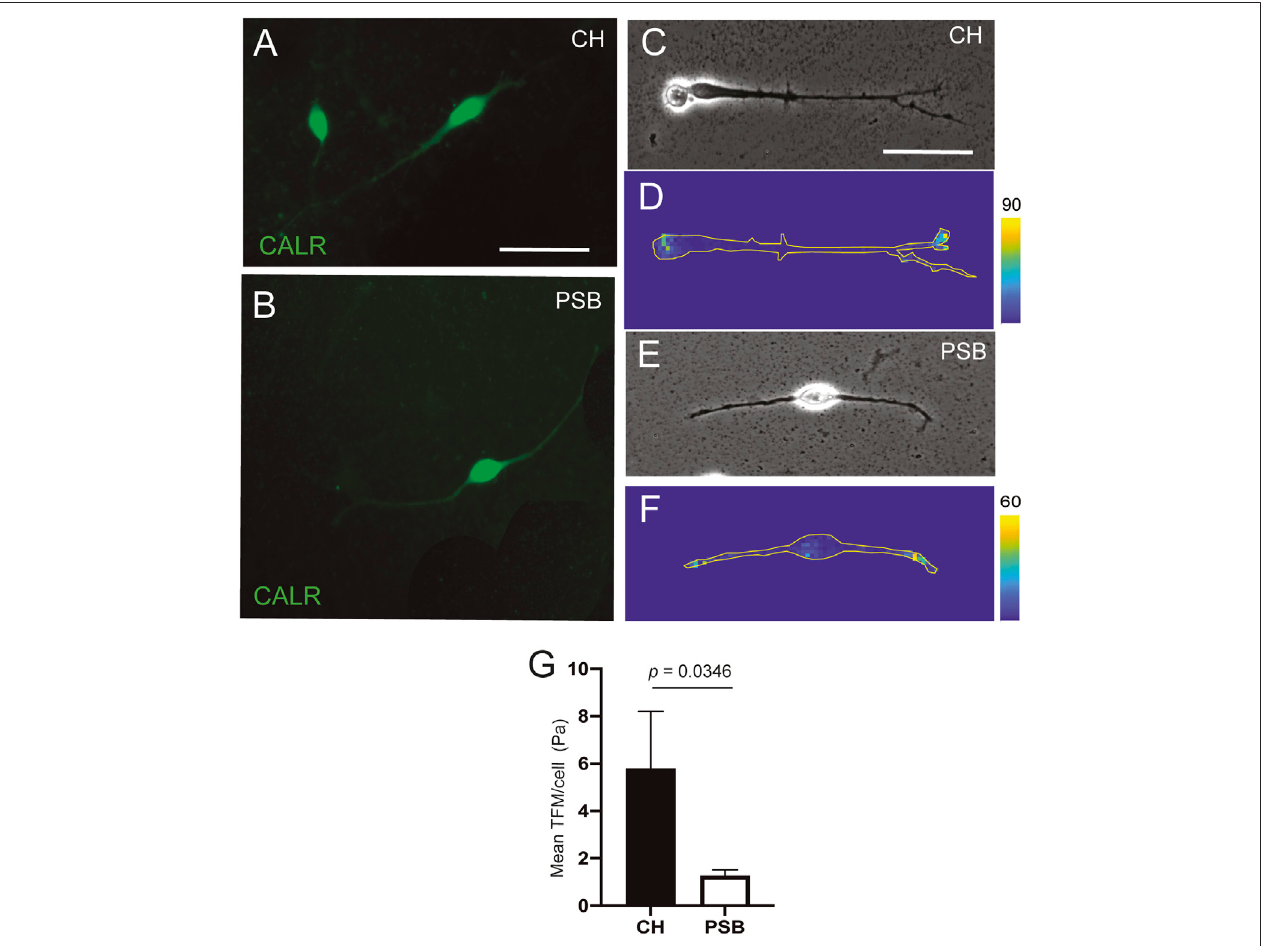
FIGURE 2 | TFM measurements of CH and PSB-derived CR cells in PAA gels (A,B) Examples of CR cells stained using CALR antibodies derived from CH (A) and PSB (B) . (C – F) Phasecontrast(cande)andconstraintforcemaps(DandF)ofCRcellsderivedfromCH (C,D) andPSB (E,F) afterTFManalysis.Forcestriggeredbythe CR cells are color-coded according to their intensity. The shape of the CR cells is outlined with a yellow contour in the constraint maps to better visualize their extent. Thesemapsrevealsthatthehighesttractionvaluesaremorphologicallylocatedatthetipsoftheirneurites,forbothCH-andPSB-derivedCRcells (G) Resultsofthe Traction Force Microscopy (TFM) analysis. The bar plots show the mean pressure (force per unit area) generated by the different CR cells. The pressure values are obtainedbydividingthemeasured forcesbythetotalareapixelsoccupiedbytheanalyzed CRcells.CH:corticalhem;PSB:pallium-subpalliumboundary.Datain(g)are presentedasmean±s.e.m..Theindicated p valuewasobtainedbyusingtheone-tailpermutationtest.Scalebars,A=50 μ mpertainstoB,C=50 μ mpertainsto (D – F) .